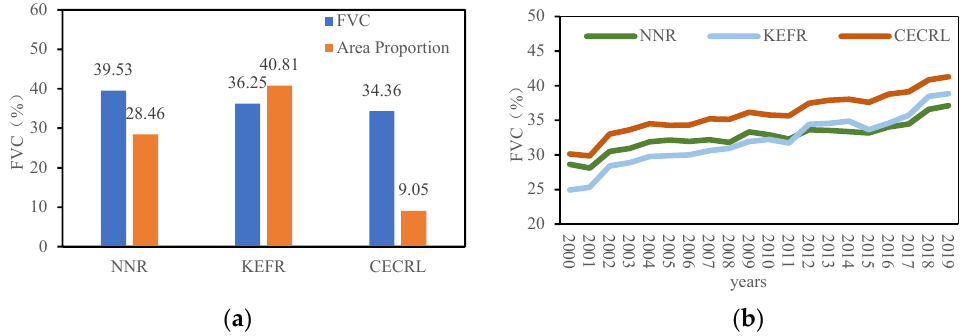
Figure 11. ( a ) FVC and the area proportion in different ecological management areas. ( b ) The changes of FVC in different ecological management areas year by year.